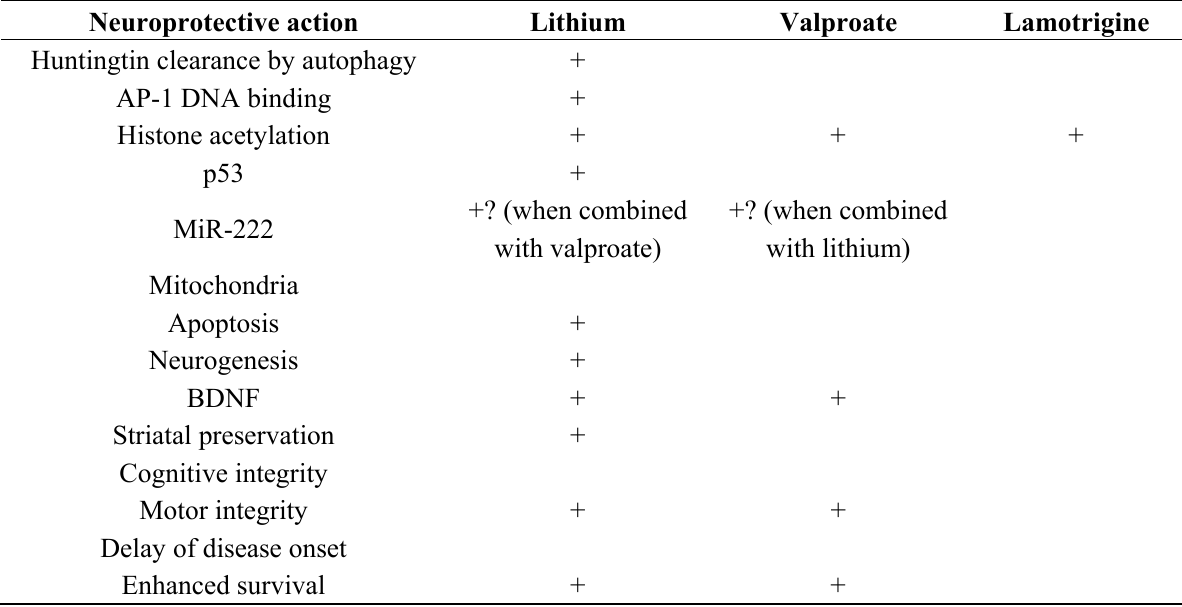
Table 6. Mood stabilizer neuroprotective effects in Huntington’s disease models. Neuroprotective action